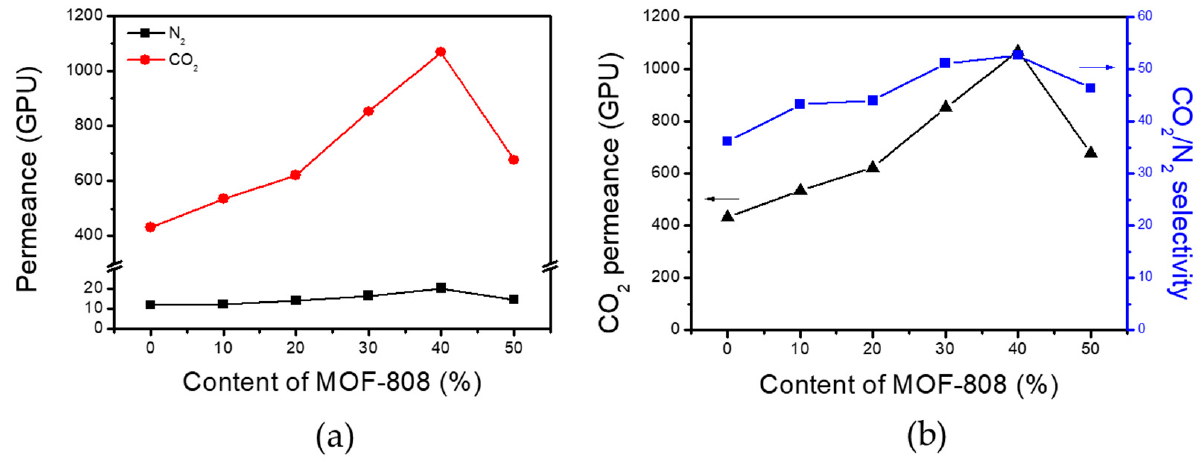
Figure 5. ( a ) CO 2 and N 2 permeance of TFC-MMMs with varying MOF-808 content. ( b ) CO 2 permeance and CO 2 /N 2 selectivity of TFC-MMMs with increasing MOF-808 content.